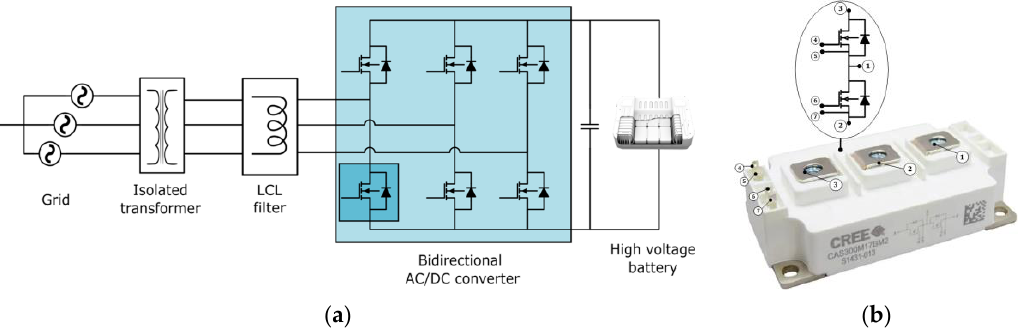
Figure 2. ( a ) Topology of the off-board charger and ( b ) detailed pinout of semiconductor under test (SiC half-bridge power module) with (1) middle point of half-bridge: source of upper MOSFET/drain of lower MOSFET; (2) source of half-bridge; (3) drain of half-bridge; (4) gate of upper MOSFET; (5) source of upper MOSFET; (6) gate of lower MOSFET; (7) source of lower MOSFET.